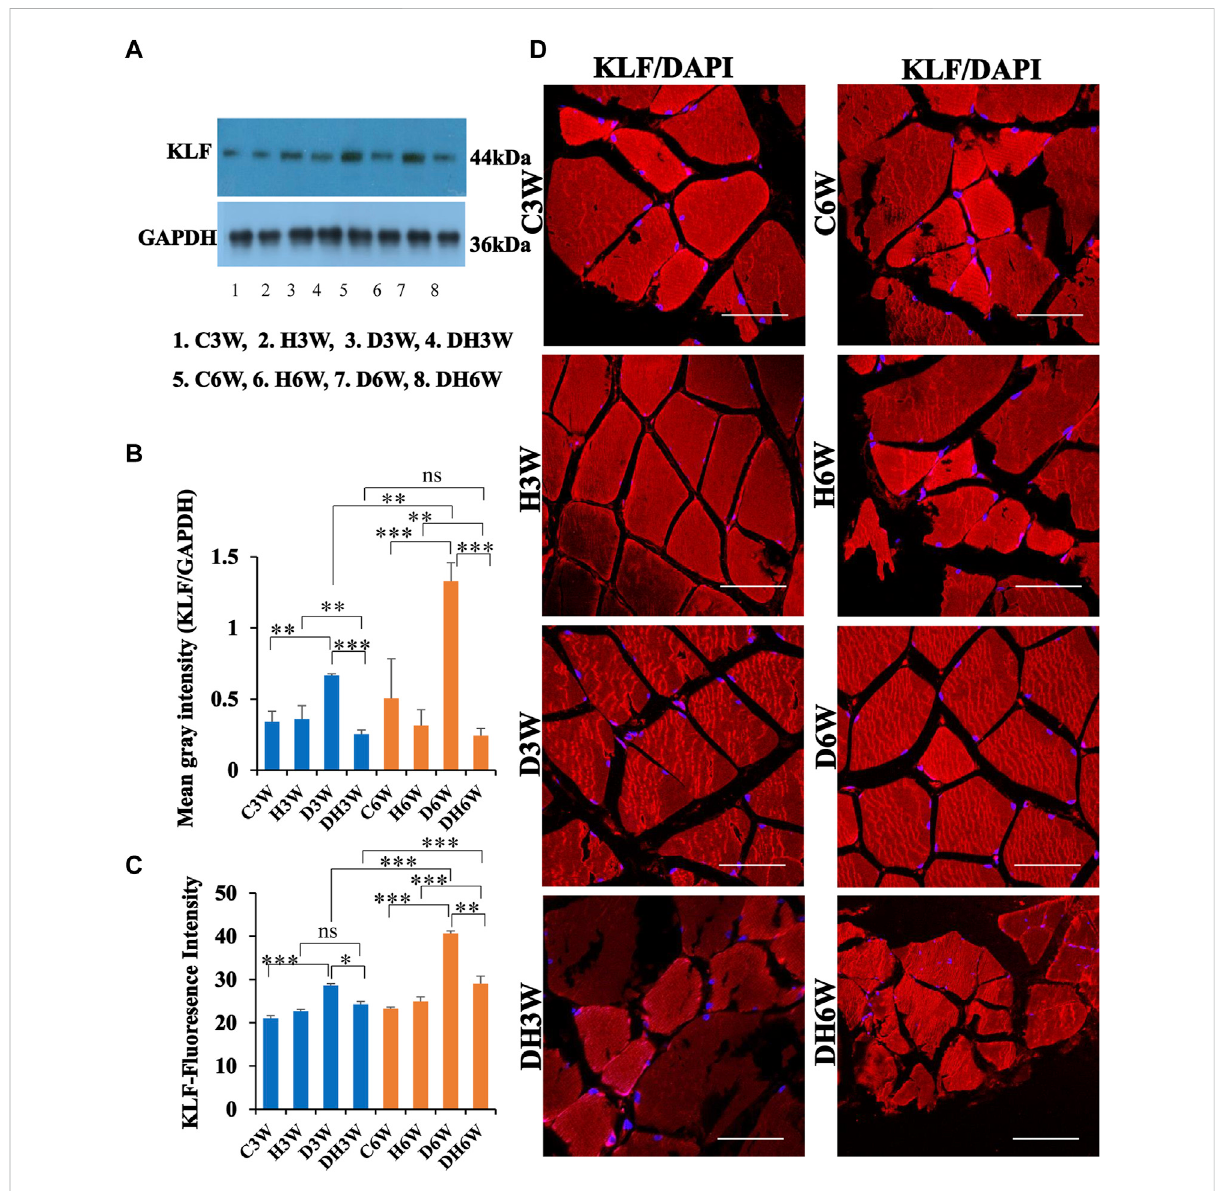
FIGURE 8 (A,B) Immunoblots probed with anti-KLF antibody (A) and the mean gray intensity of immunoblots (B) . Note the signi fi cantly increased expression of KLF (mean gray intensity) in D3W and D6W compared to C3W and C6W, respectively. KLF expression was decreased signi fi cantly in DH3W and DH6W compared to D3W and D6W respectively. There was a signi fi cant increase in KLF expression from short-term (D3W) to long-term (D6W). (C,D) KLF immuno fl uorescence intensity (C) and representative cross-section of muscle fi bers stained for anti-KLF immuno fl uorescence in short-term (left panel) and long term (right panel) experiments (D) . Western blot data of KLF expression is further supported by fl uorescence intensity measured on the anti-CD68 immunostained sections of the muscle fi bers in most of the comparisons. Note large number of muscle fi bers showing immuno fl uorescence in D3W, DH3W, D6W, and DH6W (*, p < 0.05; **, p < 0.01; ***, p < 0.001, One-way ANOVA, Bonferroni multiple comparison tests, n = 6 in all groups). Scale bar = 50